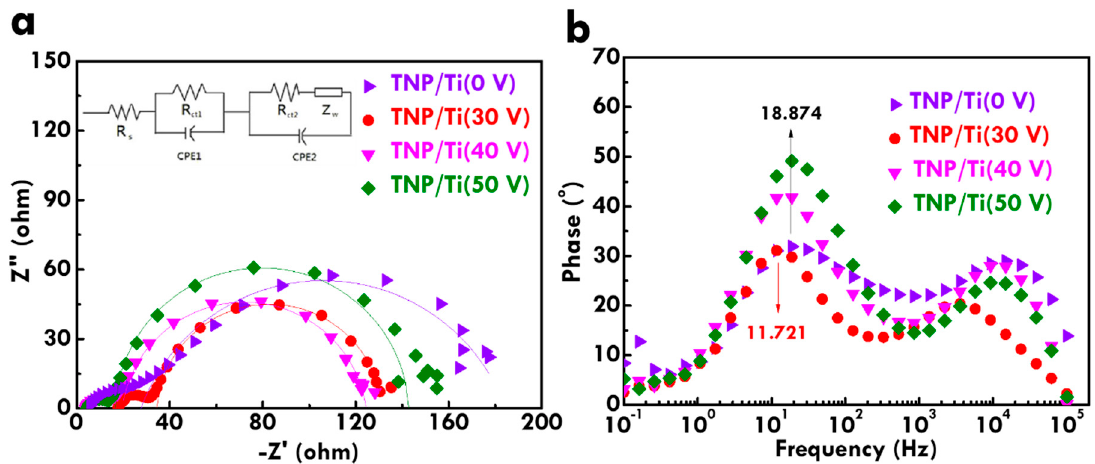
Figure 5. ( a ) Nyquist plot and ( b ) Bode plot for FDSSC with TNP/Ti wire and TNP/TNT-printed Ti wire photoanodes. Table 1. The photovoltaic parameters, charge-transfer resistance and collection efficiency for the FDSSC with TNP/Ti wire and TNP/TNT-printed Ti wire photoanodes. Photoanode